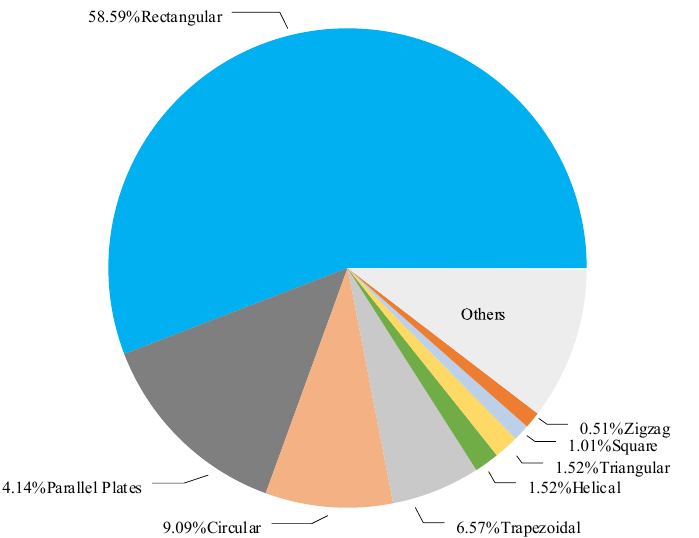
Figure 3. The cross-sectional geometries of microchannels in the published papers (adapted from Ref. [24]).